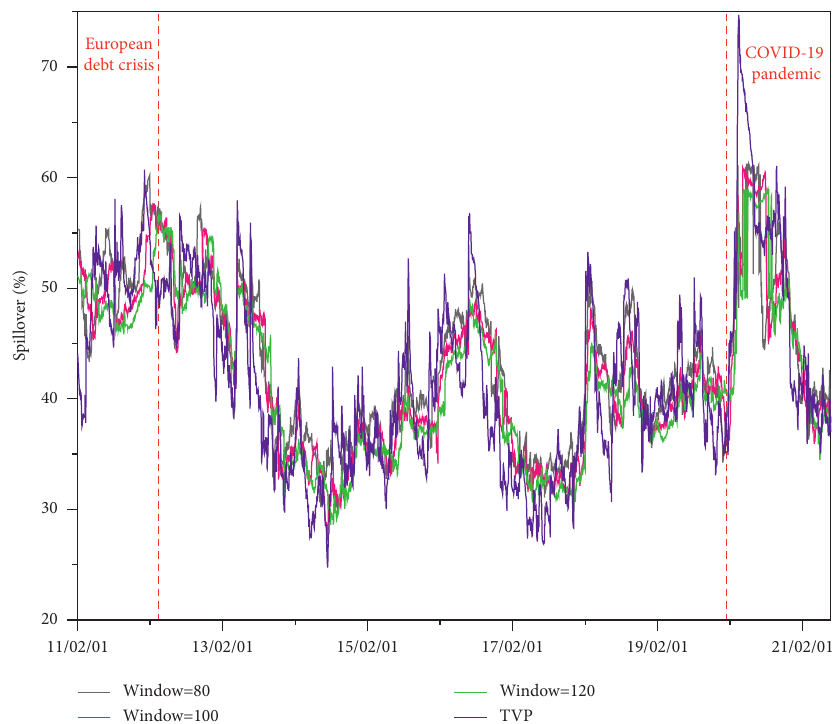
Figure 5: Dynamic return total spillover with different rolling windows and TVP-VAR. The blue line is the dynamic return total spillover for TVP-VAR. The red dotted line defines the time points that distinguish three sample phases. The three window sizes plot the dynamic return total spillover measures on the 80, 100, and 120. All abbreviations are as follows: bitcoin, gold, and commodities indices (commodities); the world stock index (world); the developed stock index (developed); and the emerging stock index (emerging). The sample period for returns is from February 2, 2011, to June 23, 2021.